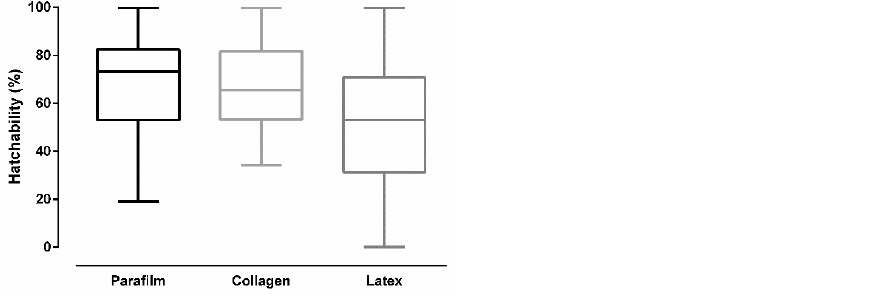
Figure 4. Egg hatchability after Aedes aegypti females were artificially blood-fed through different membranes (bars = ±SEM).